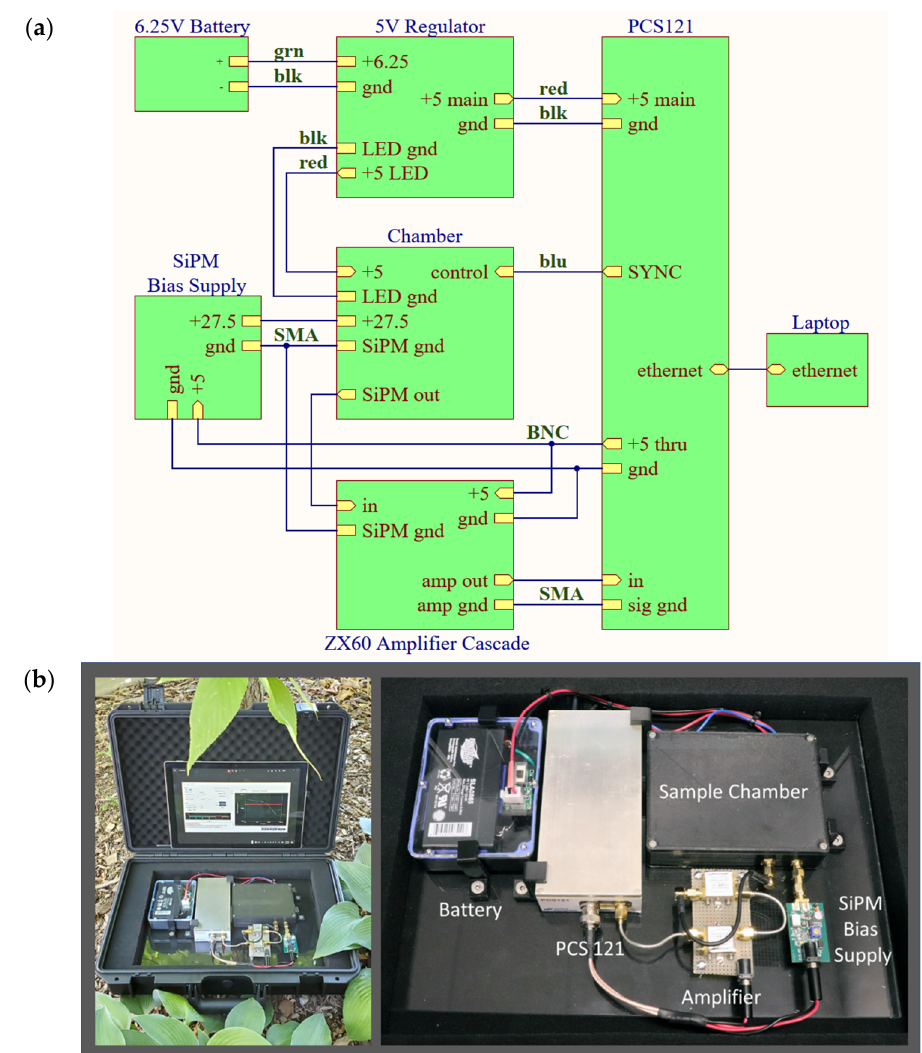
Figure 2. ( a ) Block diagram showing interconnections of modules (top). ( b ) Setup of the York DF Photon Counting Device having total footprint 30 cm × 23 cm inside a portable case. The system consists of the PCS121 High-Speed Pulse Counter, the SiPM amplifier, 27.5 V bias supply, lead-acid battery and voltage regulator, the delayed fluorescence sample chamber and a tablet user interface.